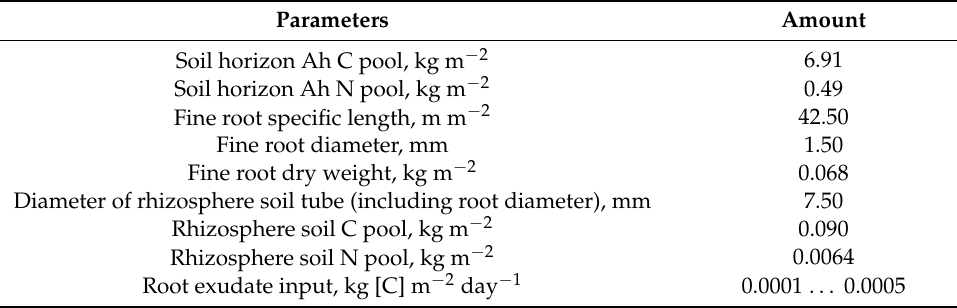
Table 4. Parameters of test soil for simulation at the level of Ah